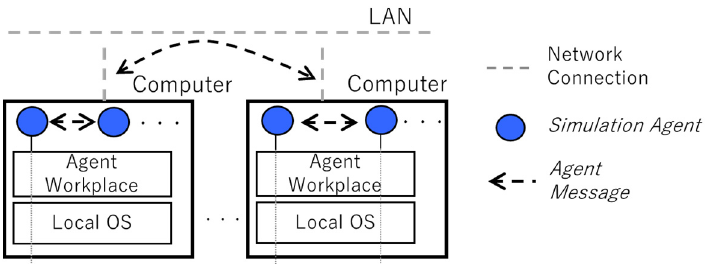
Figure 9. Composition of agents, agent workplaces and network environment.